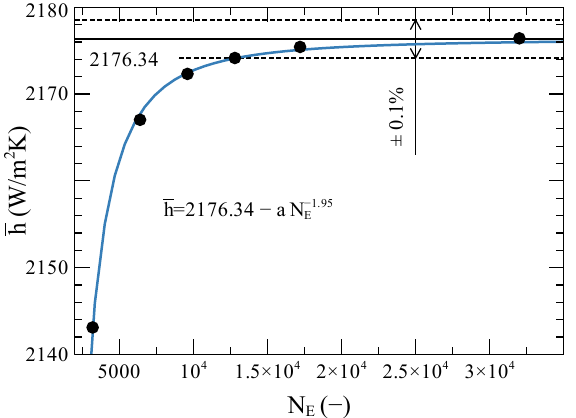
Figure 3. Grid independence study for the sought value of the average heat transfer coefficient ¯ h along the entire pipe depending on the number of elements N E . The study was carried out for water (Pr = 6.99), ω = 0.1047rad/s, Re = 497 ( ¯ u = 0.5 m/s) and for a hydrodynamically developed flow profile (setting the UDF function at the inlet).